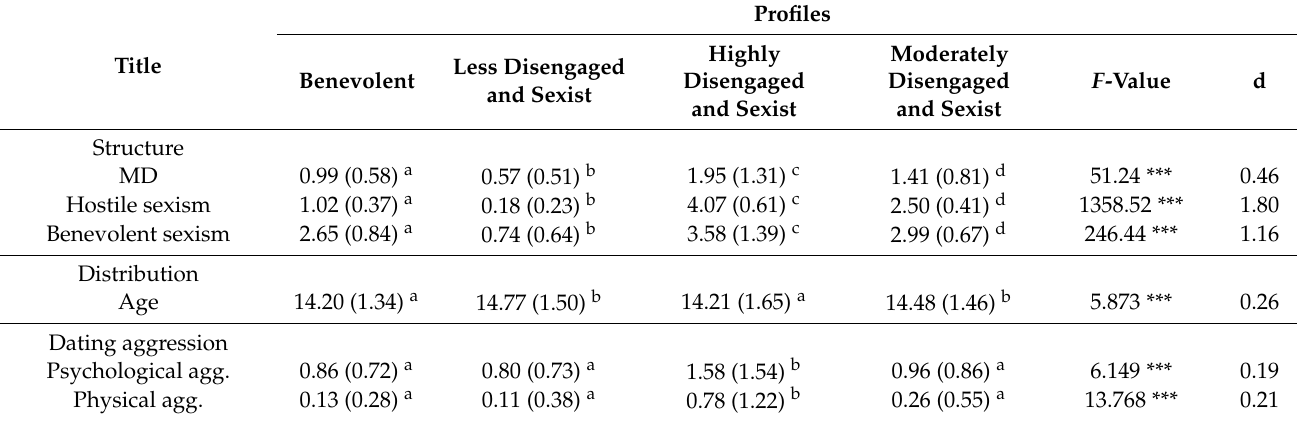
Table 5. Structure of profiles, age, and dating aggression differences among the four identified MD and sexism profiles.